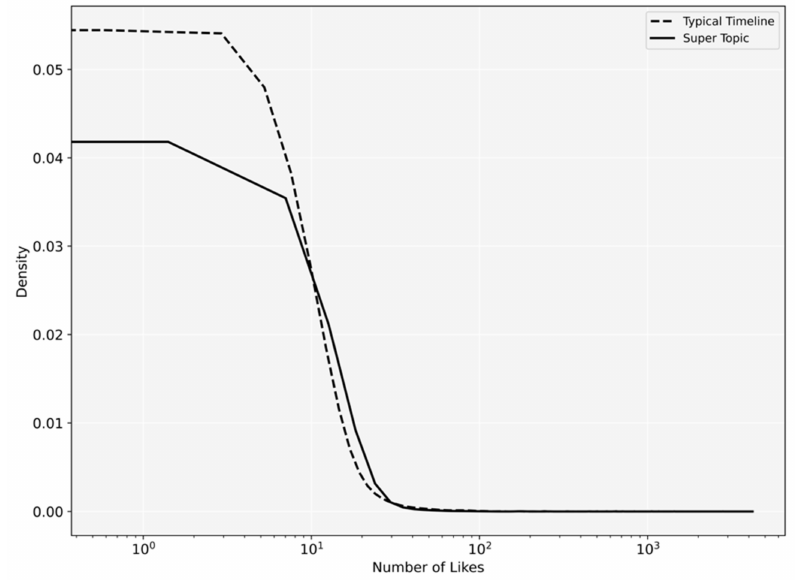
Figure 3. Probability density of likes users received in Depression Super Topic and regular timelines.